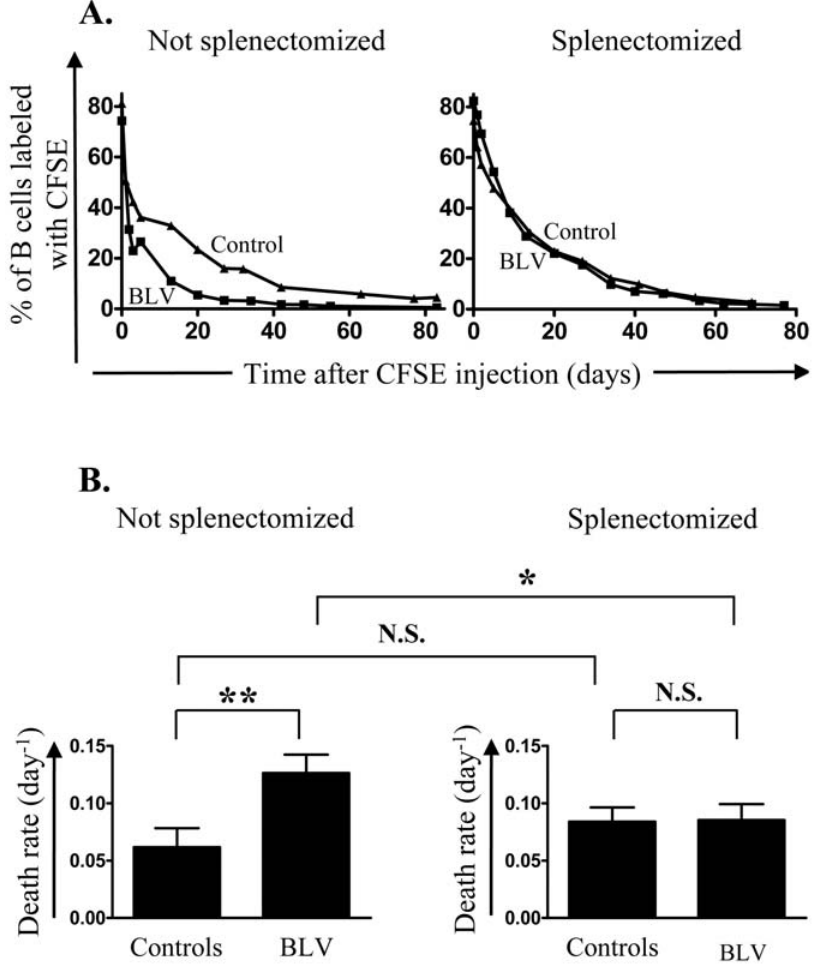
Figure 2. Evaluation of death rates in vivo. CFSE was injected intravenously in BLV infected sheep and in non infected controls. At regular interval of time, the percentage of B lymphocytes labeled with CFSE was determined by flow cytometry. A mathematical model was fitted to in vivo CFSE labeling data in B lymphocytes and death rates were estimated. Not splenectomized (left panels) and splenectomized (right panels) animals were analyzed. (A) Percentages of B cells labeled with CFSE in BLV-infected ( & ) and control ( m ) sheep. (B) Mean values ( 6 SD) of death rates. CFSE was injected in 7)infected sheep, 3 of them being splenectomized and 7 controls, 3 of them being splenectomized. Statistical relevance (n.s., not significant; p , 0.05, statistically significant*; p , 0.01, highly statistically significant**) was calculated according to the unpaired two-tailed student t test with Welch’s correction.